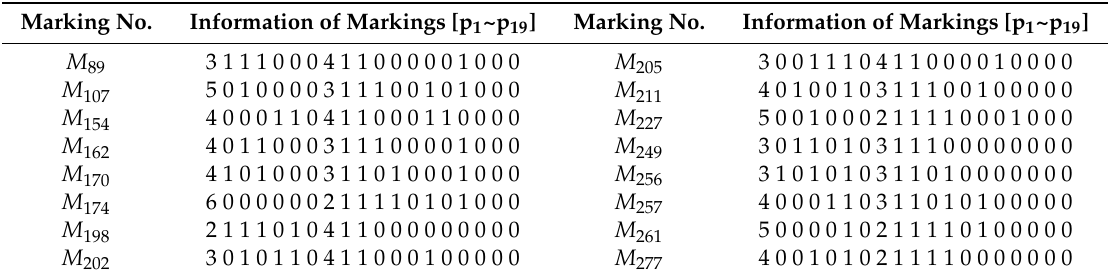
Table 4. The detailed information of all deadlock markings of Example 2.